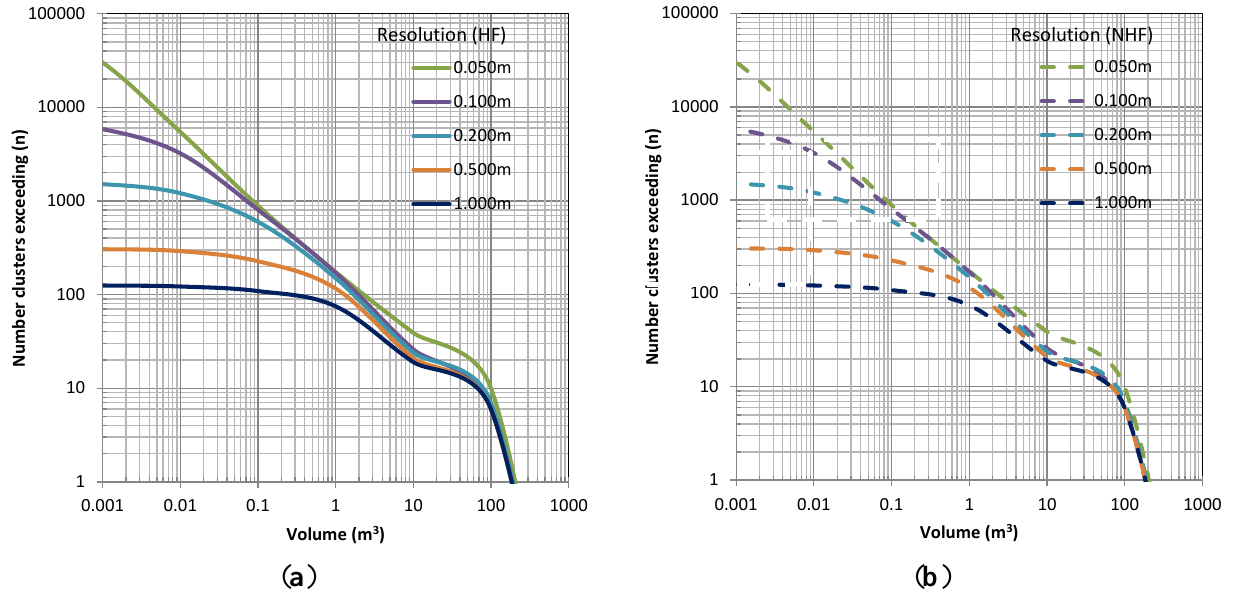
Figure 20. Comparison of magnitude–frequency curves for various resolutions and with ( a , HF) and without ( b , NHF) hole filling between 2013 and